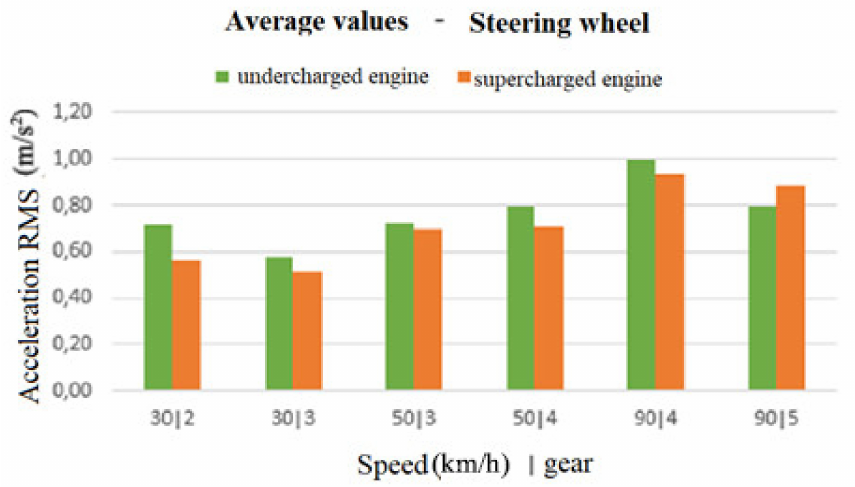
Figure 7. Comparison of the averaged values of dominant harmonic vibrations measured at the steering wheel for the older (green) and the newer